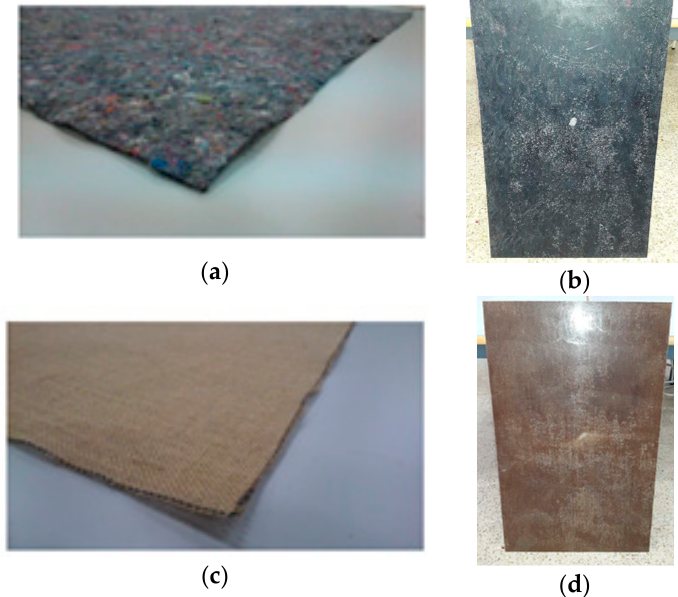
Figure 4. ( a ) Textile waste blanket; ( b ) textile waste treated with biodegradable resin board; ( c ) jute fiber blanket; ( d ) jute fiber treated with biodegradable resin